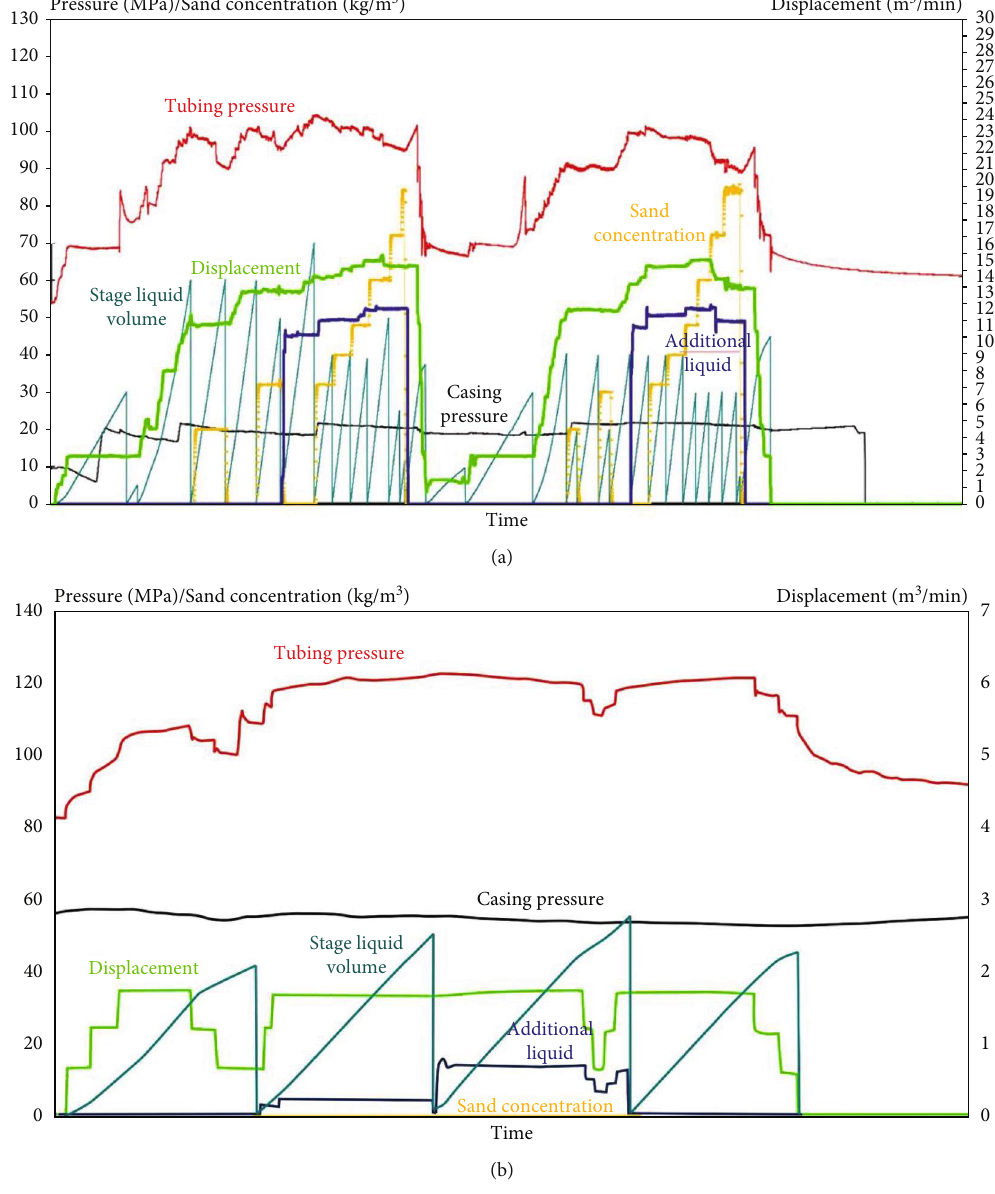
Figure 18: Comparison of fracturing operation curves. (a) Taking the fracturing operation curves of Section 4 as an example, it shows that under a displacement of 14m 3 /min and an oil pressure of 100 ~ 90 MPa, the fractures gradually expand and reach the equilibrium state. (b) Fracturing operation curve of a failed well in the Kuqa depression. In the case of a displacement of 1.5m 3 /min, the oil pressure may rise rapidly to the upper limit of 120MPa and fi nally cause the failure of transformation due to di ffi cult